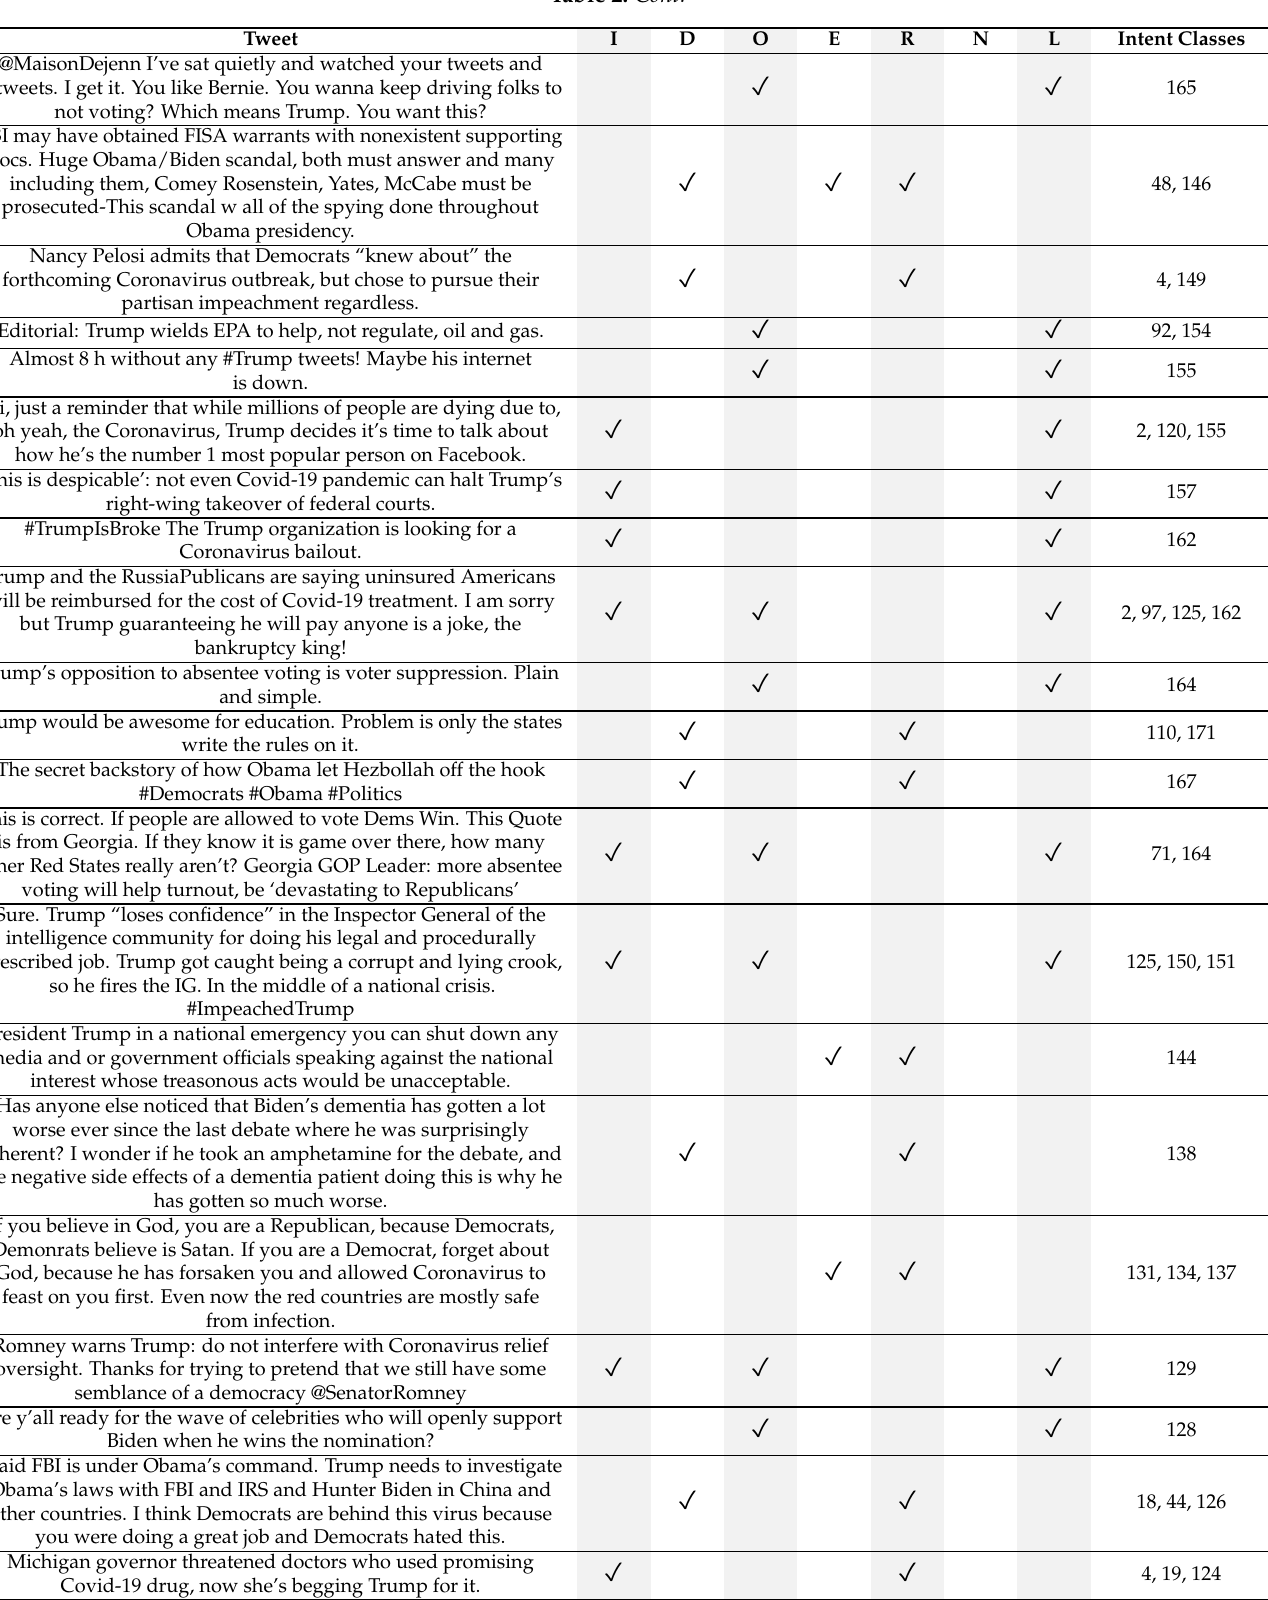
Table 2. Example Tweets and their classes: I stands for information, D for disinformation, O for opinion, E for extreme opinion, R for rightist, N for neutral, and L for leftist.